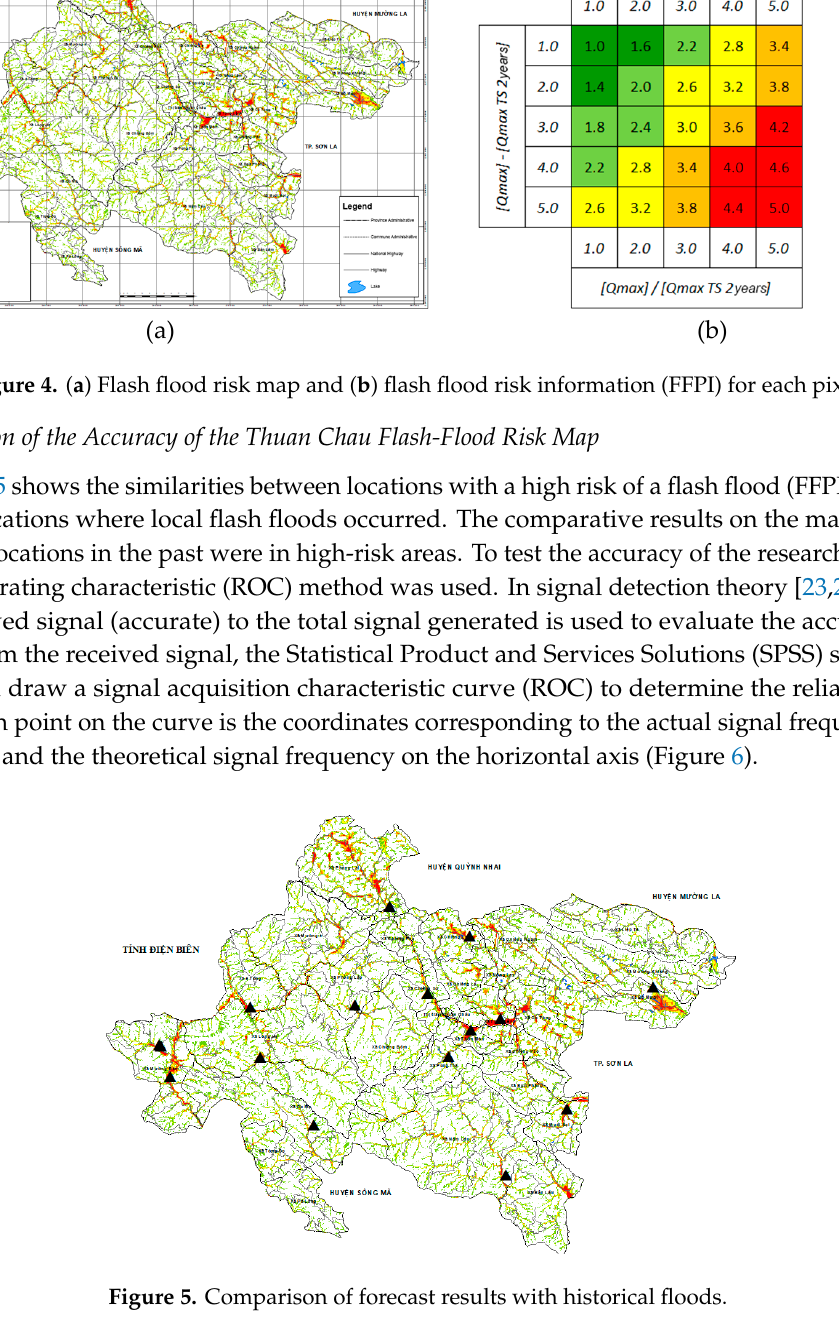
constructed from the historical